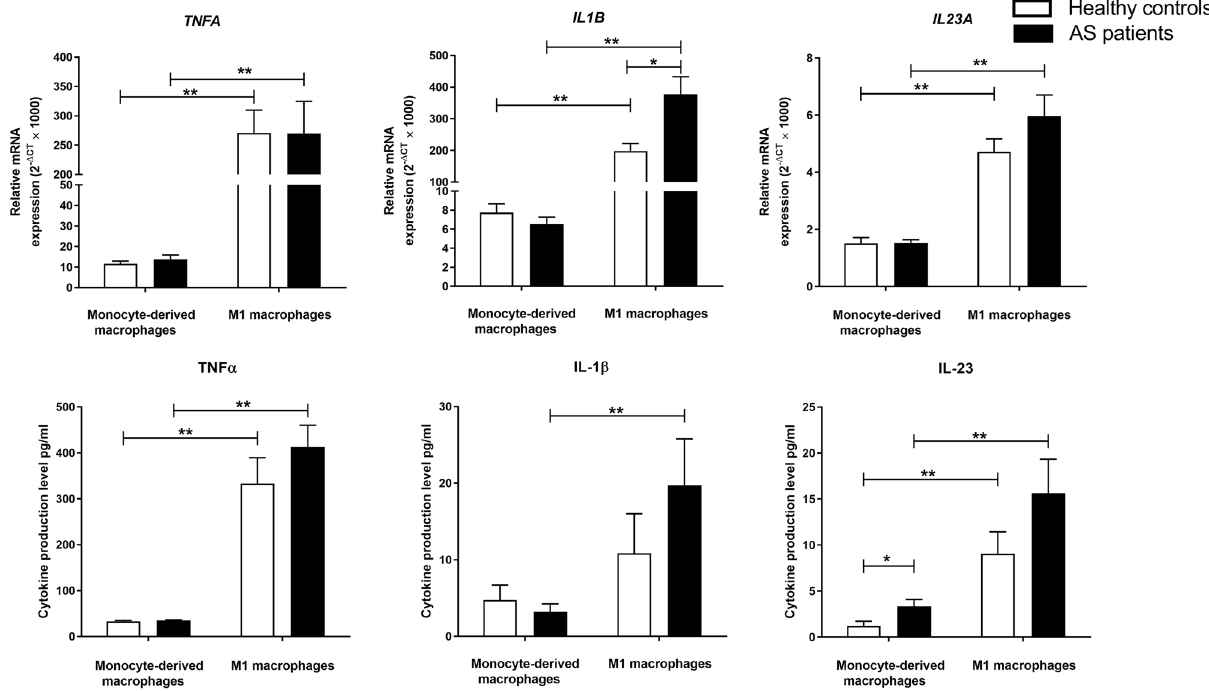
Figure 1. The mRNA expression and the protein production of pro-inflammatory cytokines in monocyte- generated and M1 macrophages from AS and healthy individuals. M1 macrophages from AS patients significantly expressed an elevated level of IL1B gene. The gene expression levels of IL1B , TNFA , and IL23A and the protein production levels of IL-23 and TNF-α were significantly elevated in macrophages after their differentiation to M1 type. However, only macrophages from AS patients produced a significantly elevated level of IL-1β after differentiation to M1 type. The data are presented as the mean ± SEM (* P ≤ 0.05, ** P ≤ 0.01, *** P ≤